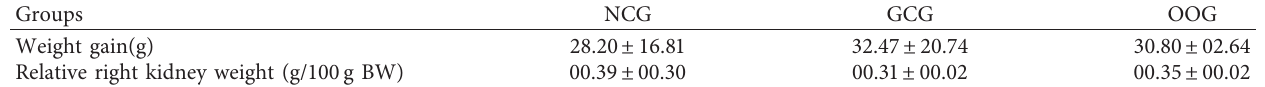
Table 2: Effect of ODSO administration on bodyweight gain and right kidney weight variation.